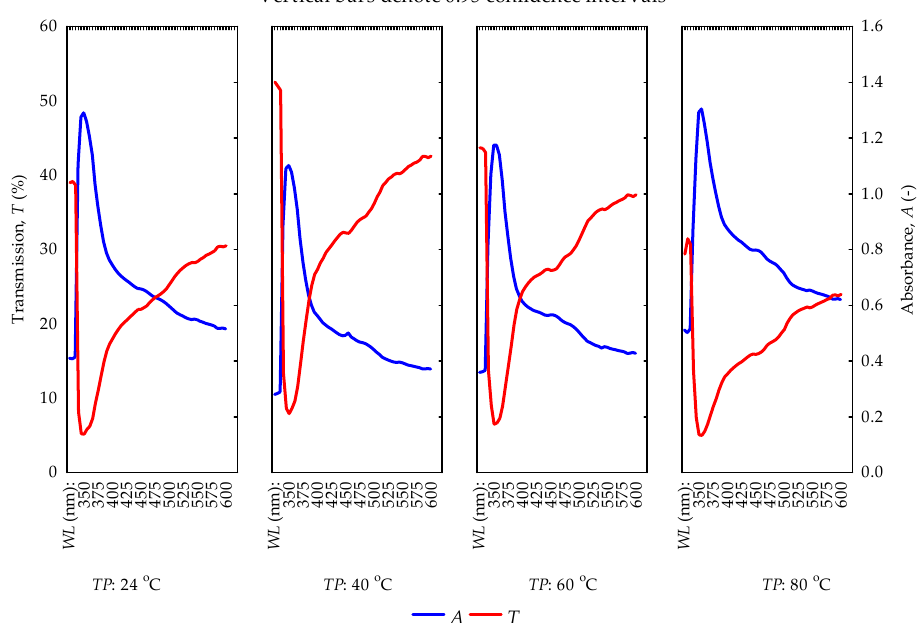
Figure 7. Transmittance and absorbance versus wavelength (nm) curves at various pretreatment temperatures (24 °C—unheated as the control).